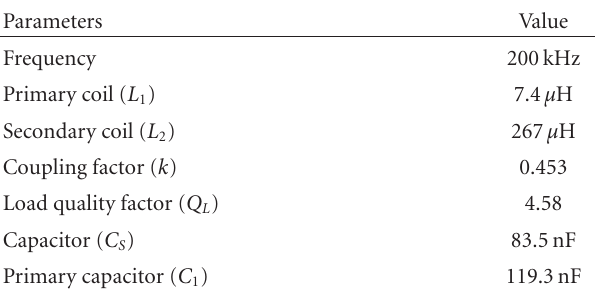
Table 1: Inductive link